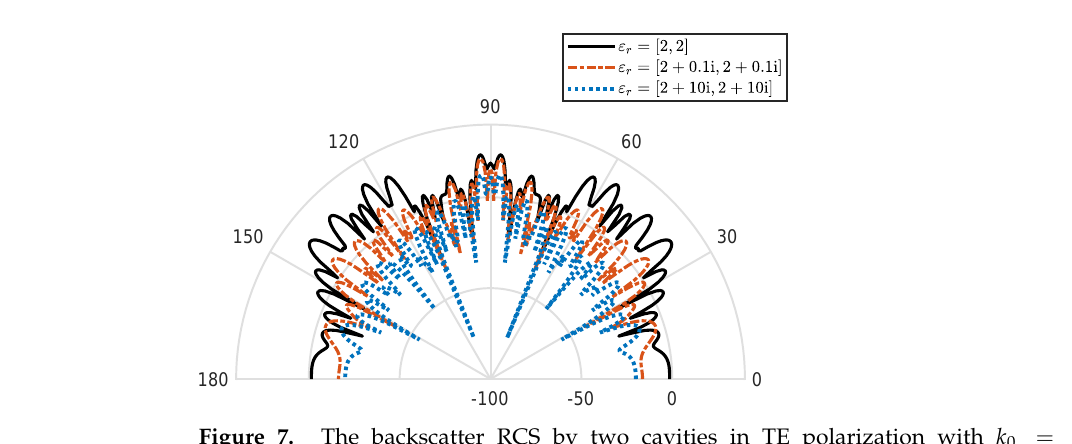
Figure 7. The backscatter RCS by two cavities in TE polarization with k 0 = 8 π m − 1 on 512 × 512 meshes for the media [ 2,2 ] , [ 2 + 0.1i,2 + 0.1i ] and [ 2 + 10i,2 + 10i ] .